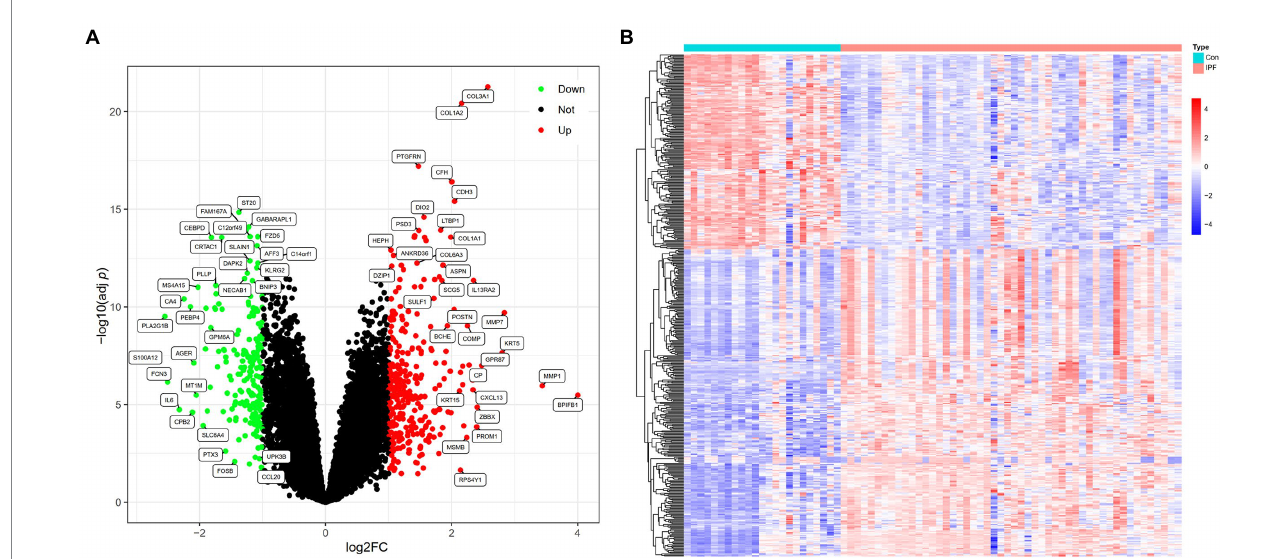
FIGURE 1 DEGs between patients with IPF and healthy individuals. (A) Volcano plot of DEGs identified based on the threshold of |log2FC| values of >1 and adj p - values of <0.05; the green (Down) and red (Up) dots represent downregulated and upregulated genes in patients with IPF, respectively; the black dots (Not) represent genes that are not differentially expressed between patients with IPF and healthy individuals. (B) Heatmap demonstrating the expression levels of the DEGs in 23 healthy individuals (Con) and 50 patients with IPF (IPF); red represents high expression, and blue represents low